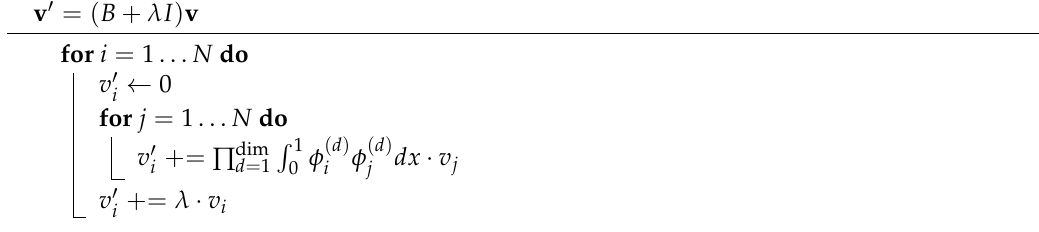
Algorithm 2: The streaming algorithm for computing the matrix-vector multiplication